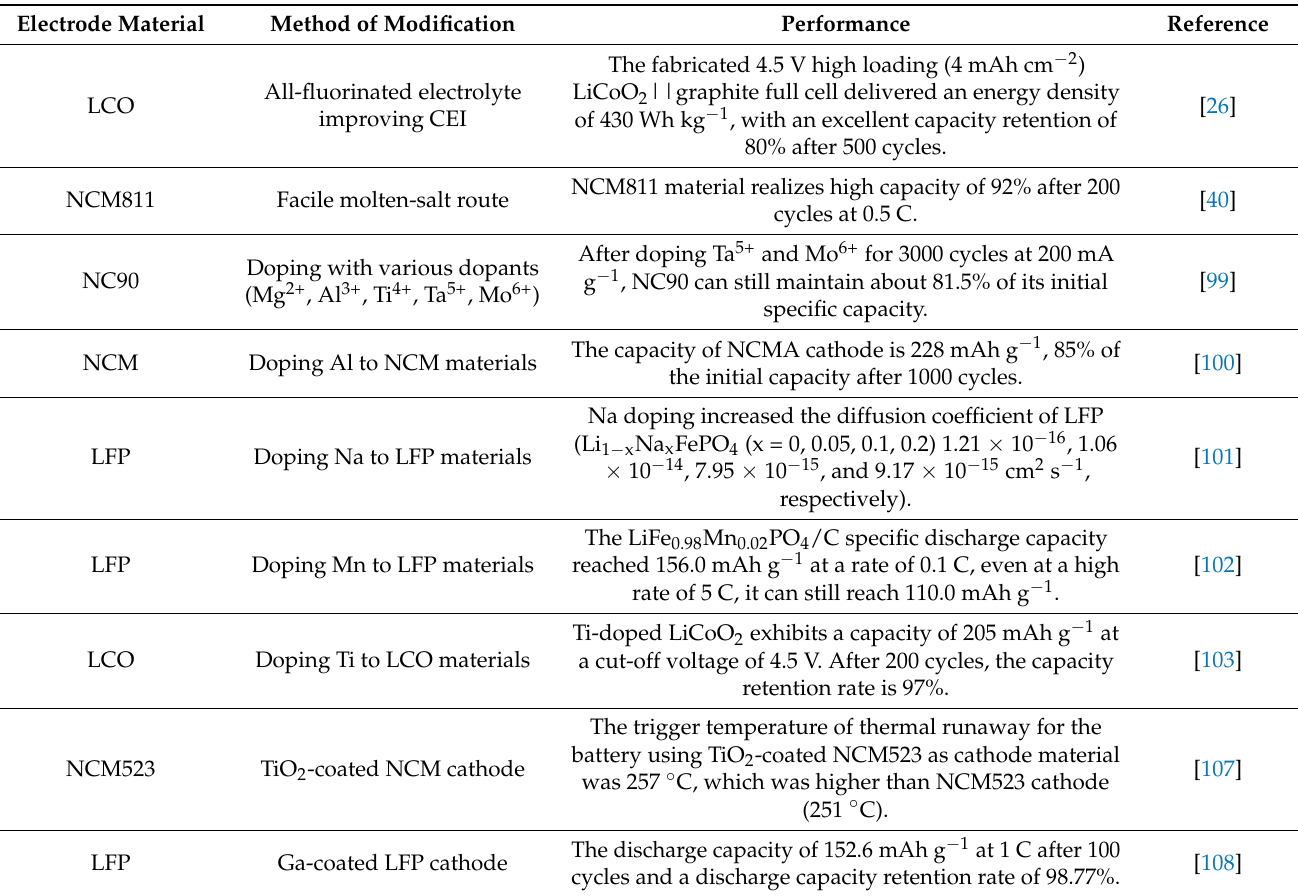
Table 3. Modification of cathode